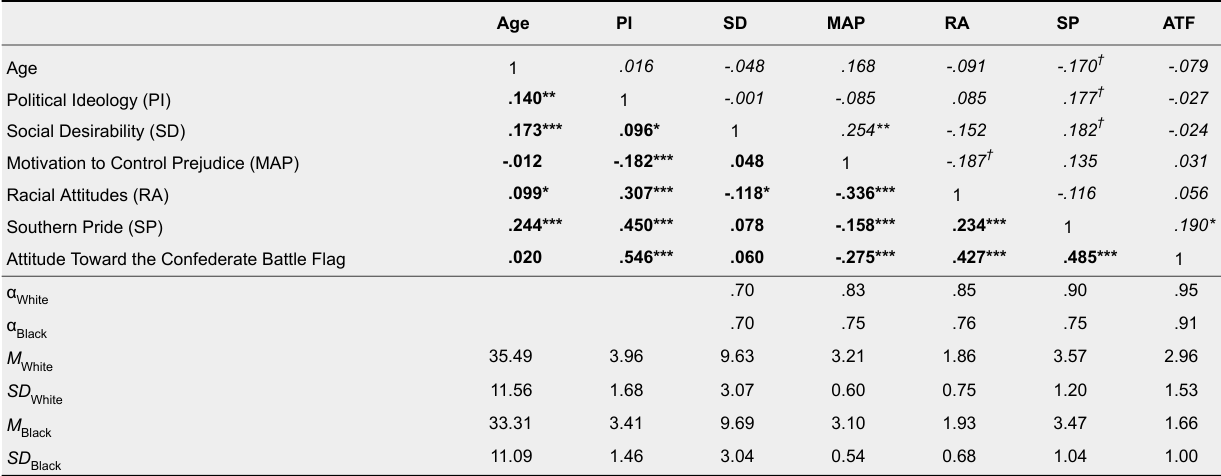
Bivariate Correlations, Means, and Standard Deviations Among All Variables for Both White and Black Samples